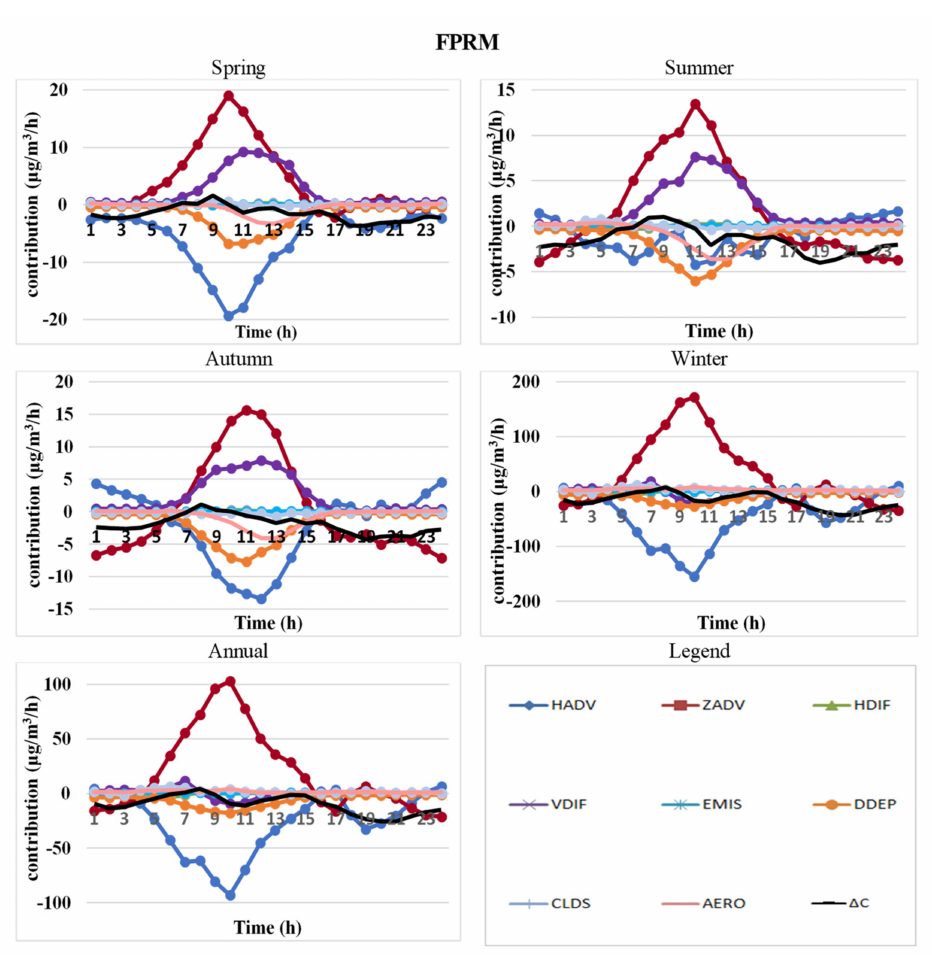
Figure 19. Annual, seasonal and diurnal course of the contribution of the different dynamic and chemical processes of the formation of FPRM concentrations ( µ g/m 3 /h) averaged for Bistritsa for the period